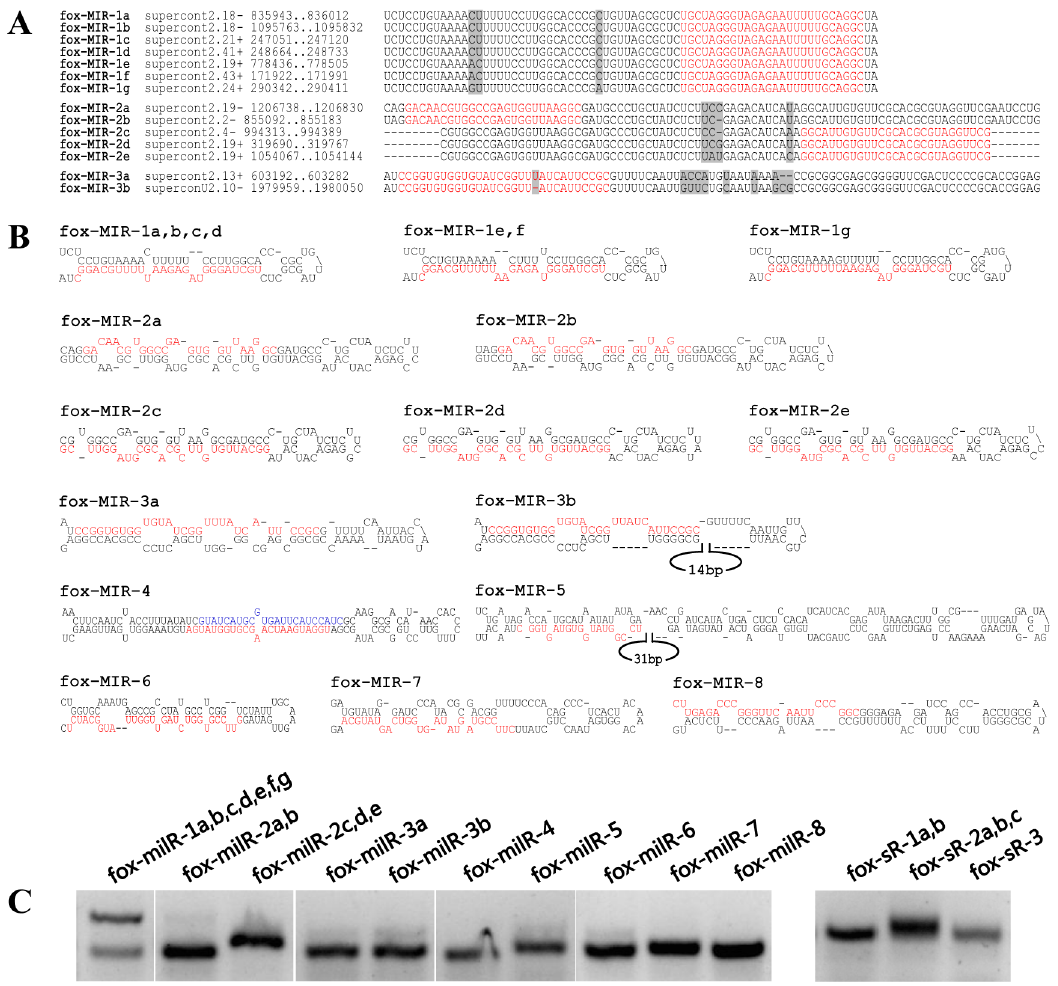
Figure 2. milRNAs identified in this study. A: Multiple sequence alignment of fox-milRNA precursors. Red sequences represent mature milRNAs and gray parts indicate low similarity. B: Secondary structures of fox-milRNA precursors. The red and blue sequences represent mature and star (milRNA*) sequences, respectively. C: Expression analysis of fox-milRNAs and small RNAs by RT-PCR experiments. Total RNA was extracted for seven- day-old mycelia and directly ligated with universal oligos at the 3 9 end. After reverse transcription, specific forward primer and common reverse primer could detect a given small RNA. Small RNAs with high abundance are more apt to get positive results. Two bands of fox-milR-1 suggested that the precursor and mature sequences were both amplified and